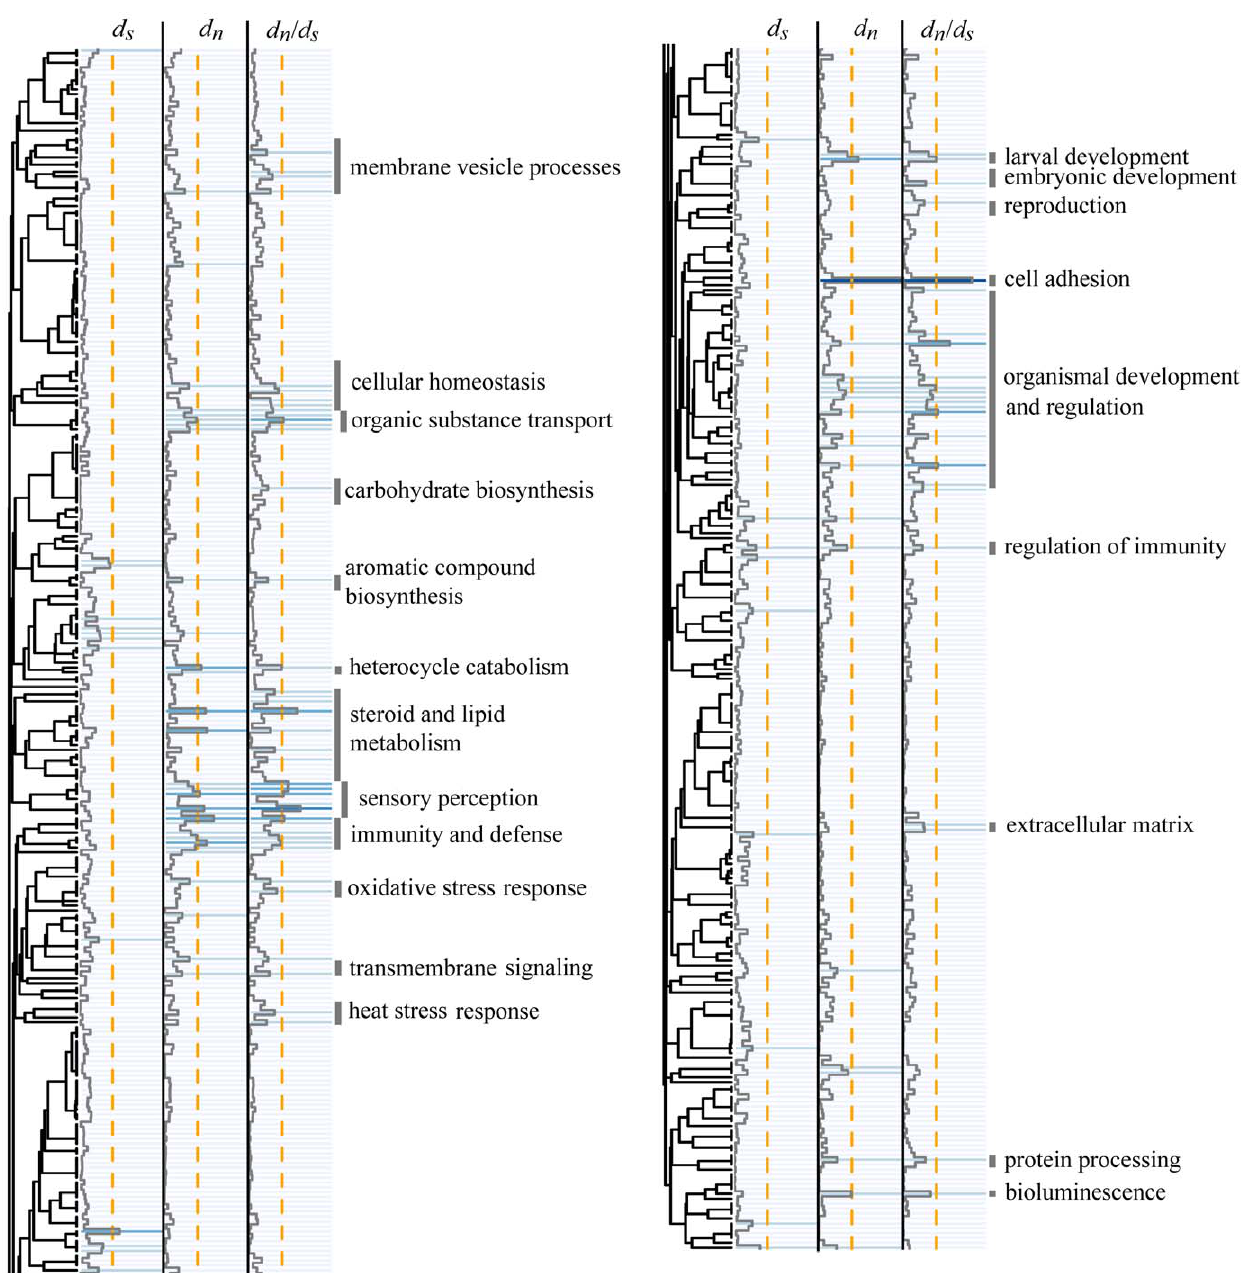
Figure 2. Detection of biological processes experiencing accelerated protein sequence evolution. The dendrogram reflects the proportion of orthologs shared between different categories in our dataset (see Material and Methods). The colors of the corresponding cells and the overlying trace line represent P -values of Mann-Whitney U test for elevated d S , d N , and d N /d S values. The first transition to the darker color signifies P , 0.05 in an individual comparison. The dashed orange line indicates the 10% false discovery rate cutoff.